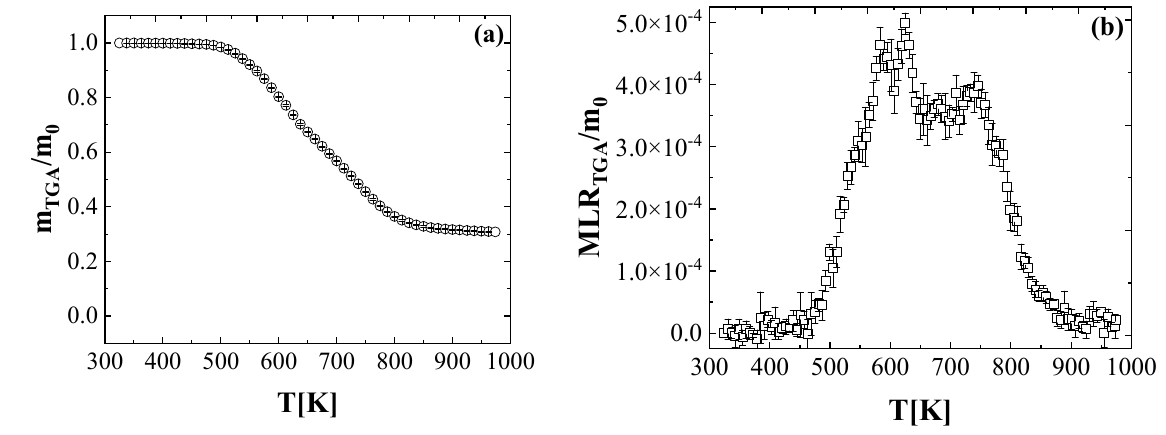
Figure 2. Experimental ( a ) normalized total mass and ( b ) normalized mass loss rate as a function of the temperature, obtained at a heating rate of 10 K min − 1 in nitrogen.